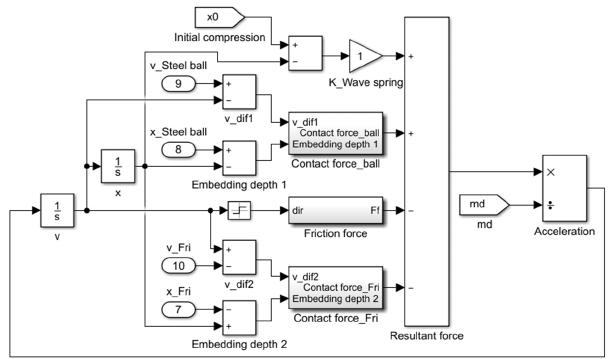
Figure 7. Braking torque calculation sub ‐ module.